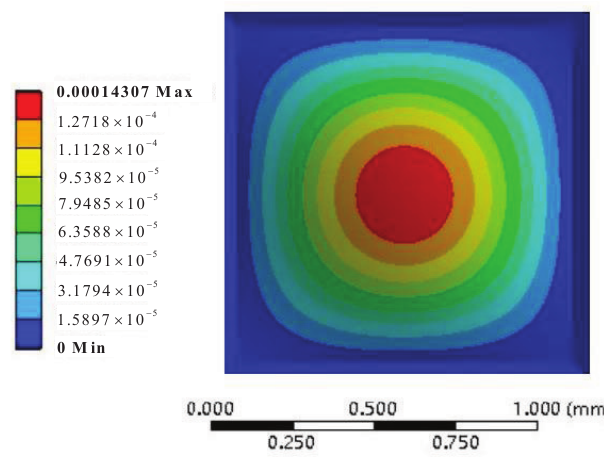
Figure 7. The deformation nephogram of silicon cup with Finite Element Analysis.